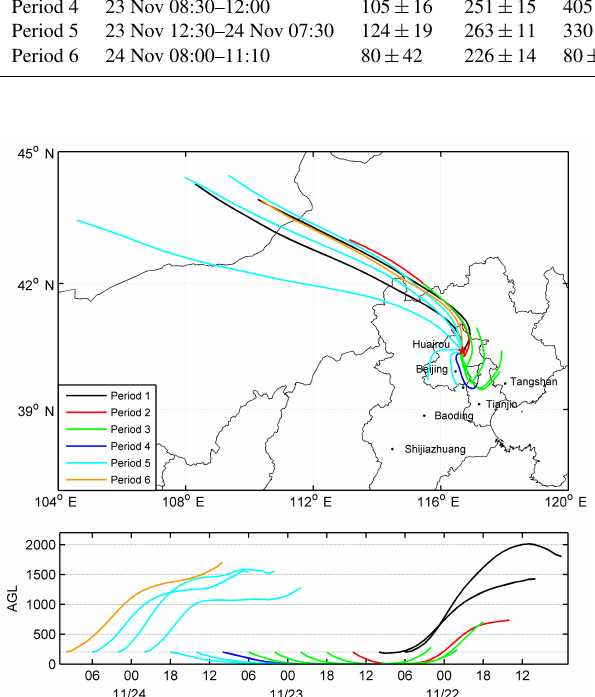
Figure 5. The 24h back trajectories starting at 200 m above ground level in Huairou site were calculated every 4h (at 00:00, 06:00, 12:00, and 18:00local time) during the selected air pollution